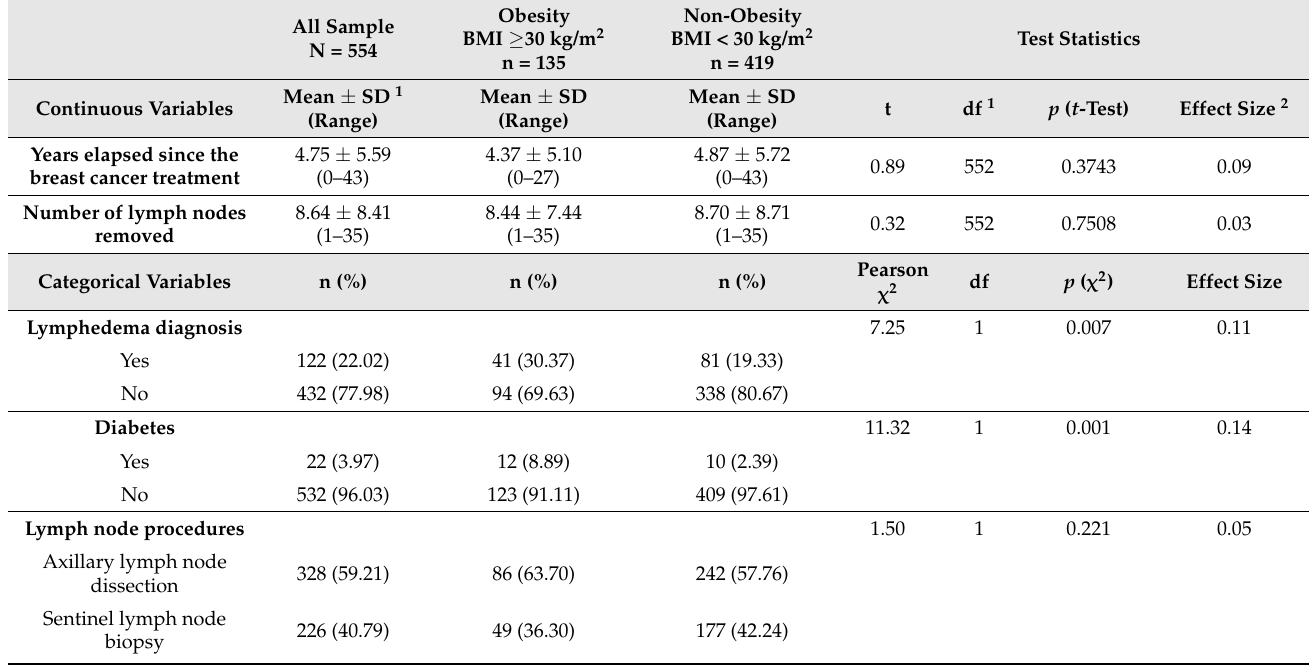
Table 2. Clinical characteristics of participants ( N =